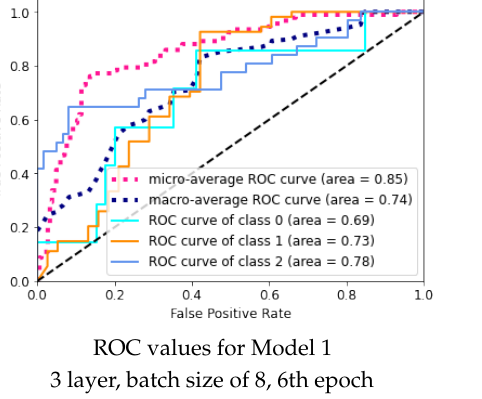
Figure 11. ROC curves for the 6 best